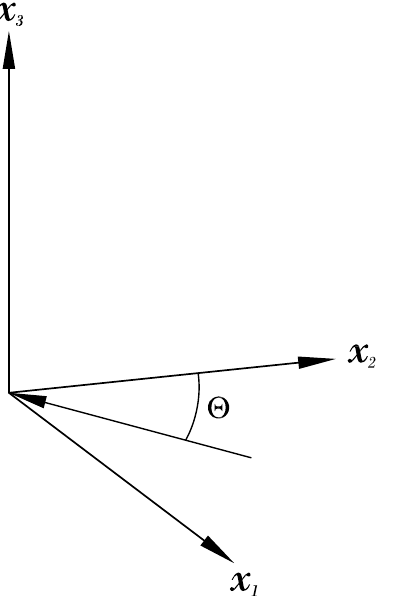
Figure 2. Standard meteorological convention of depicting the mean wind